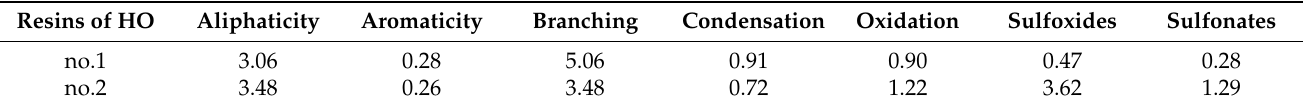
Figure 1. Fourier IR spectra of the resins of HO no. 1 ( a ) and HO no. 2 ( b ). Table 2. Spectral coefficients of the resins.